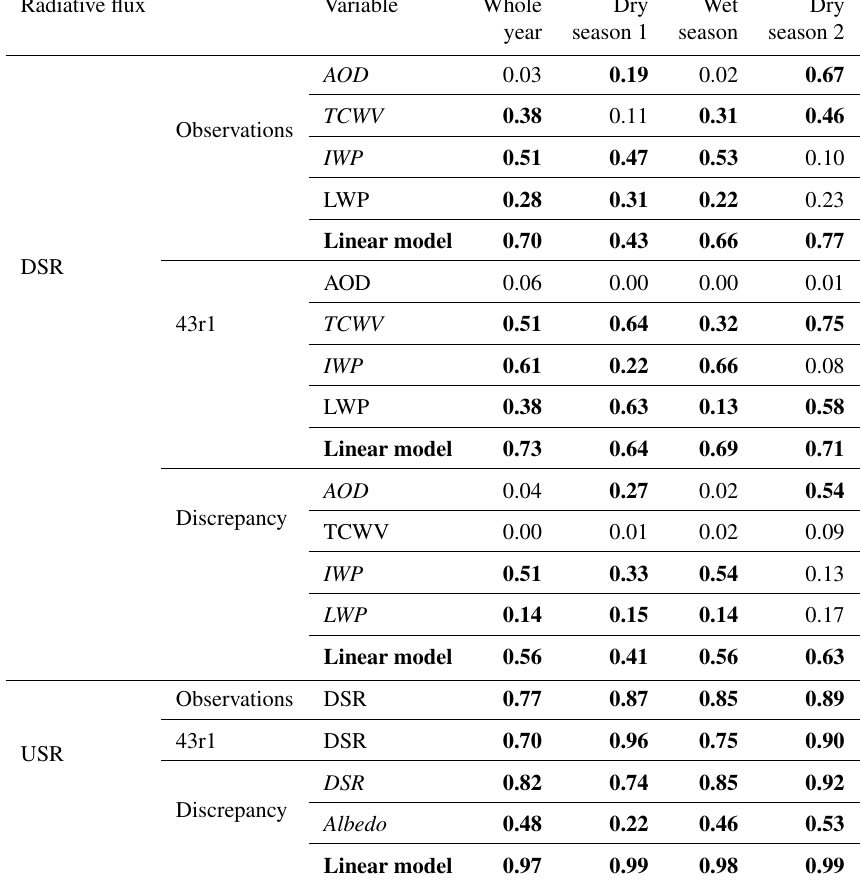
Table 4. Shortwave surface fluxes: r 2 values from correlations between observed and 43r1 USR and DSR, and their discrepancy, to other variables for the whole year (days 7–341), first dry season (days 7–125), wet season (days 126–301) and second dry season (days 302–341); statistically significant (to p ≤ 0.001) values are in bold. Italics indicate which variables were used in the linear